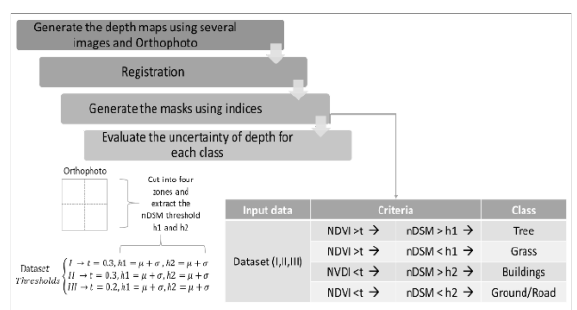
Figure 1. Details on the dataset.